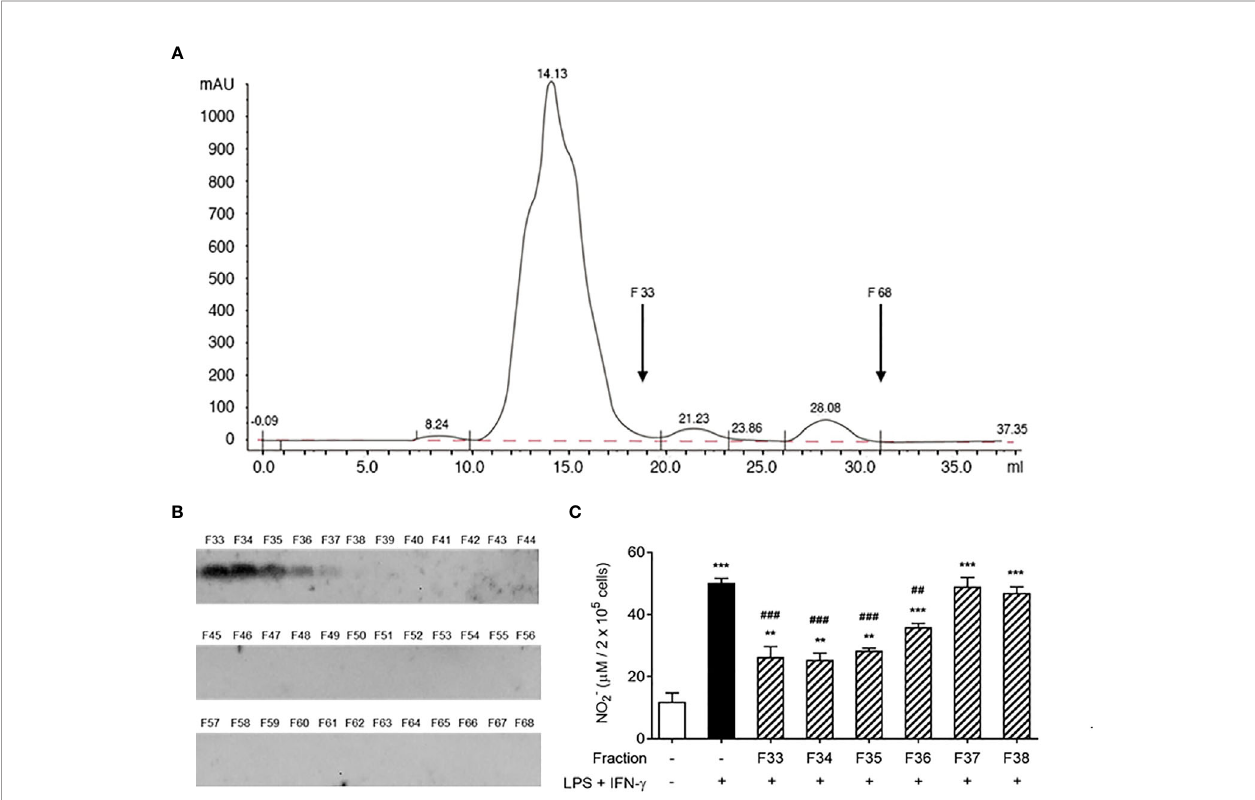
FIGURE 4 | Native salivary AeMOPE-1 inhibits nitric oxide production by macrophages. (A) SGE was fractionated by HPLC using a column that resolves peptides, fractions were eluted at 0.5 ml/minute and their absorbance monitored at 280 nm wavelength. The arrow indicates the range of low molecular fractions (F33 to F68). (B) Western Blot of F33 to 68 revealed with serum from animals immunized with syn-AeMOPE-1. (C) Macrophages were pre-incubated with each fraction from F33 to F38 (representing the low molecular weight fractions), stimulated with LPS + IFN- g (10 ng/mL of each) for 48 hours, and nitric oxide production was measured by Griess reaction. Results are expressed as the mean ± SEM from three independent experiments assayed in duplicate. ** P ≤ 0.01 and *** P ≤ 0.001 versus unstimulated/untreated cells; ## P ≤ 0.01 and ### P ≤ 0.001 versus LPS+IFN- g -stimulated cells – One-way